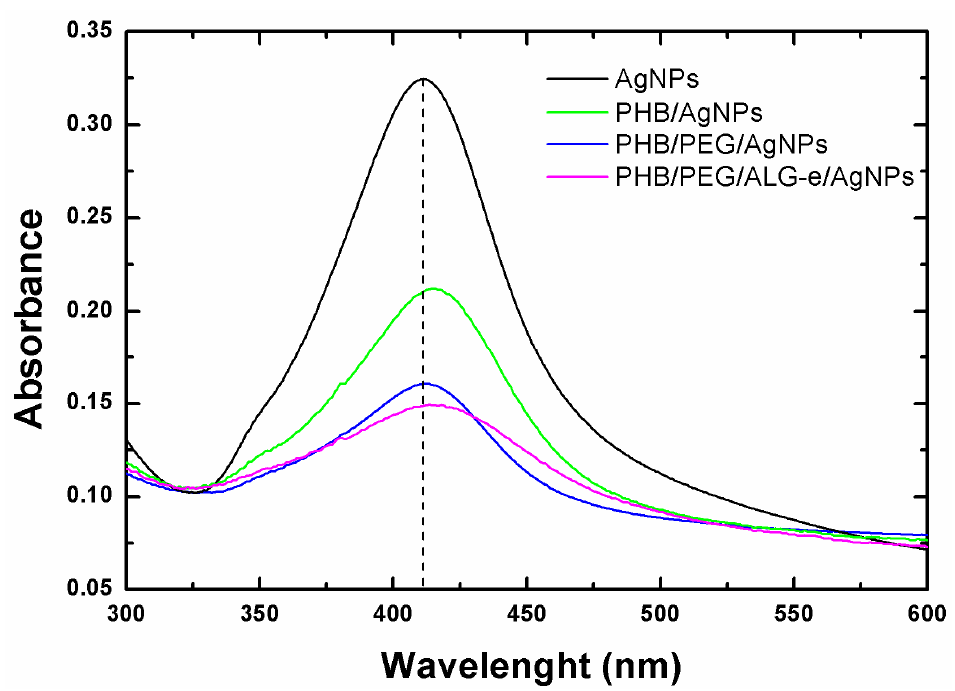
Figure 3. UV-vis spectra of supernatants from each film-forming suspension containing